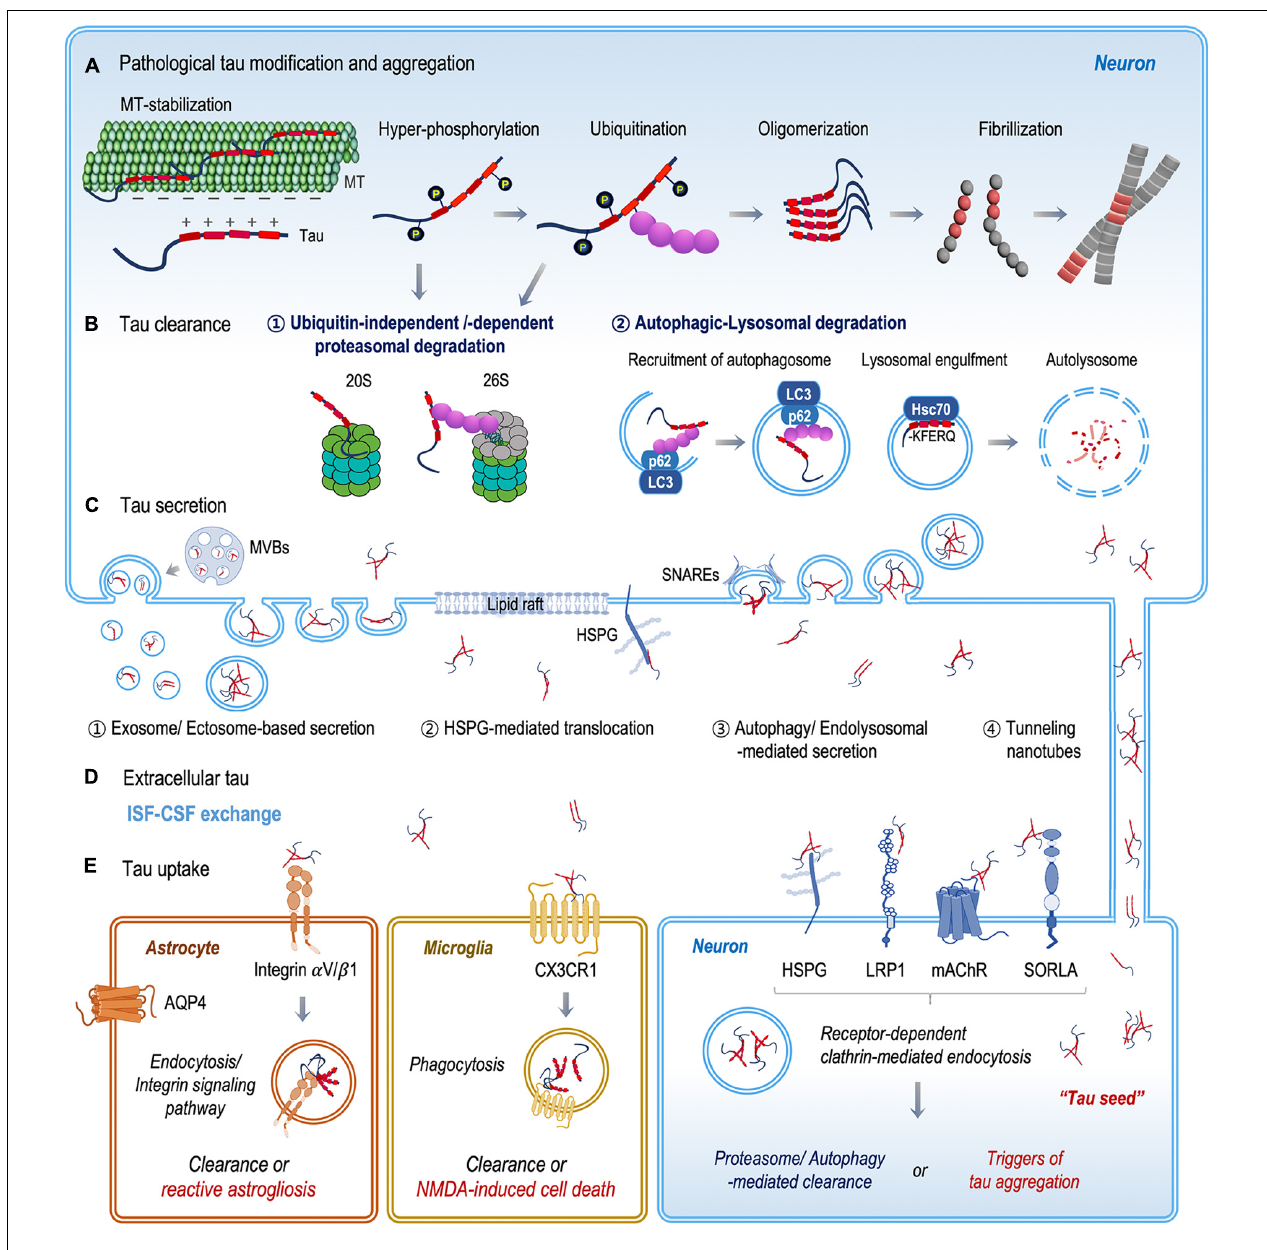
FIGURE 1 | Schematic illustration of the fate of tau protein between clearance and transmission. (A) Mis-localized tau undergoes various post-translational modifications, such as phosphorylation and ubiquitination. Chemically and structurally modified tau becomes aggregated and accumulated in the cytoplasm. (B) Mis-folded and aggregated tau proteins are degraded by the ubiquitin–proteasome and autophagosome-lysosomal systems. (C) Tau proteins are released into the extracellular space both as a free protein and in vesicles, through (1) vesicular and (2–4) non-vesicular secretion pathways. (D) Extracellular tau proteins are eliminated through ISF–CSF exchange within the glymphatic system or are taken up by neurons, microglia, and astrocytes. (E) In recipient neurons, extracellular tau proteins bind specific tau receptors (HSPG, LRP1, mAChRs, and SORLA) and are internalized by receptor-dependent clathrin-mediated endocytosis. Extracellular tau clearance by microglia and astrocytes includes the binding and internalization of tau via the CX3CR1 receptor in microglia and the integrin α V/ β 1 receptor in